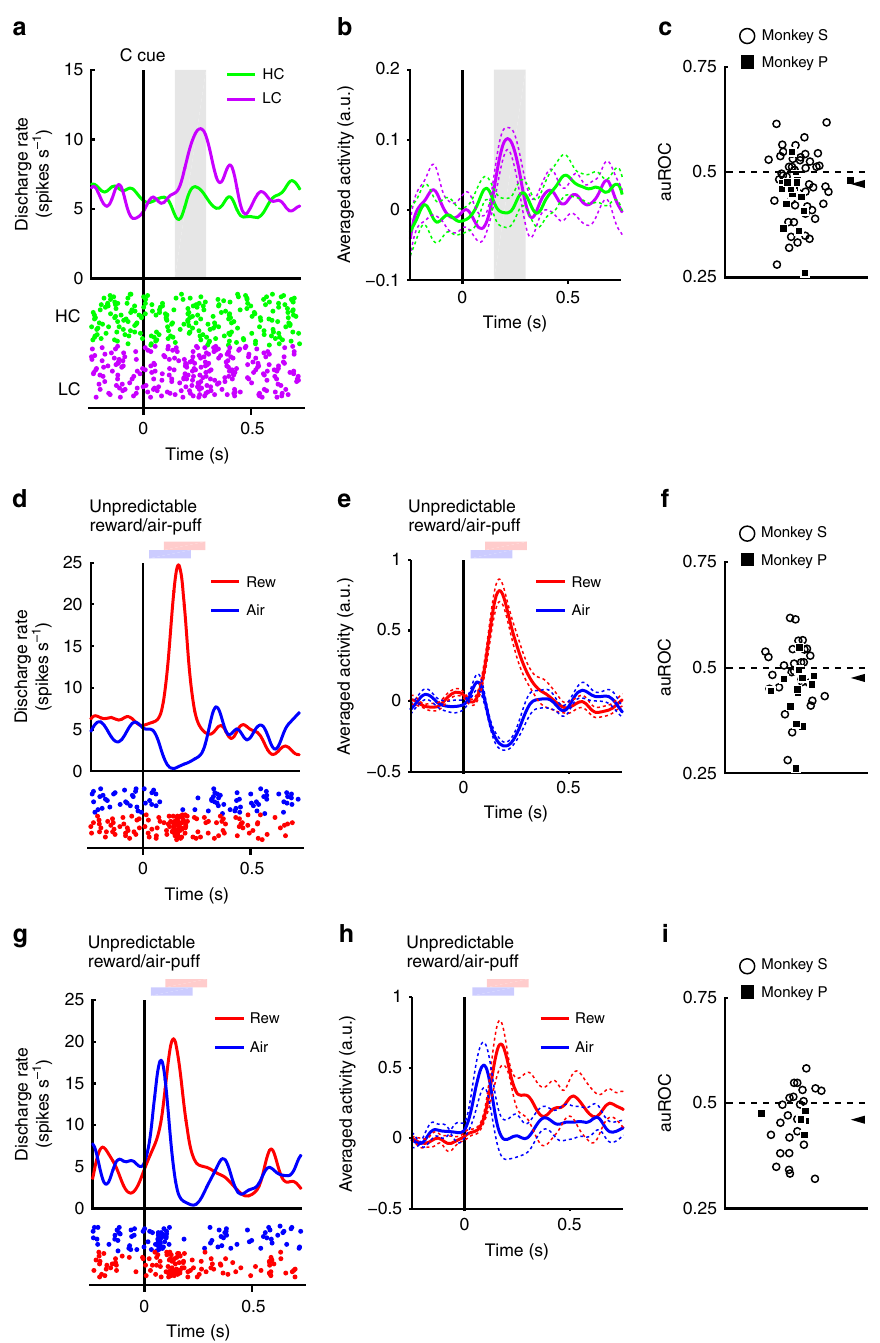
Fig. 3 Dopamine neuron responses to cost cues. a A representative dopamine neuron response to the cost cues. The spike density functions were calculated from the normalized activity of a dopamine neuron recorded from the monkey P. The colored lines indicate the spike density functions and colored dots indicate the spike timing. Green and purple colors indicate activity in the high-cost and low-cost trials, respectively. The vertical line indicates the timing of the cost cue presentation. The gray-colored area indicates the period to calculate the fi ring rate as the response to the condition cues. b Population-averaged activity of the dopamine neurons recorded from monkey P to the condition cues. The solid lines the dashed lines represent mean and SEM, respectively. c The distribution of the areas under the ROCs to quantify the effect of the predicted cost on the neuronal response to the cost cue. Filled squares and open circles indicate data from monkey P and S, respectively. The arrowhead indicates the median of the auROC (0.47). d , g Representative responses of the motivational value type dopamine neuron ( d ) or salience type dopamine neuron ( g ) to the unpredictable reward or air-puff. Red and blue curves indicate the response to unpredictable reward and unpredictable air-puff, respectively. The vertical line indicates the timing of the unpredictable reward or air-puff delivery. Pale red and blue squares indicate the period to calculate the fi ring rate as the response to the unpredictable reward or air-puff. e , h Population-averaged activity of the motivational value type dopamine neurons ( e ) or salience type dopamine neurons ( h ) to the unpredictable reward or air-puff. f , i The distribution of the auROCs calculated from the motivational value type dopamine neurons ( f ) or salience type dopamine neurons ( i ). The arrowheads indicate the medians of the auROCs ( f 0.48; i